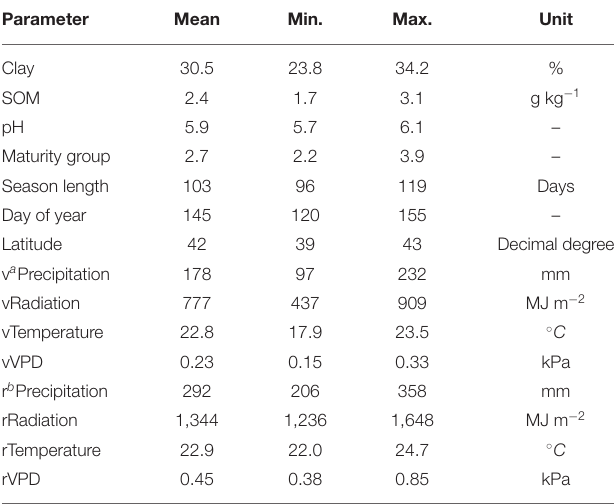
TABLE 2 | Soil (clay; soil organic matter, SOM; pH, all at 15-cm soil depth), crop/site (maturity group, season length, day of year—from January 1 to sowing time, and latitude), and weather (precipitation, radiation, temperature, and vapor-pressure deficit, VPD); covariable descriptions: mean, maximum, minimum, range, and unit of